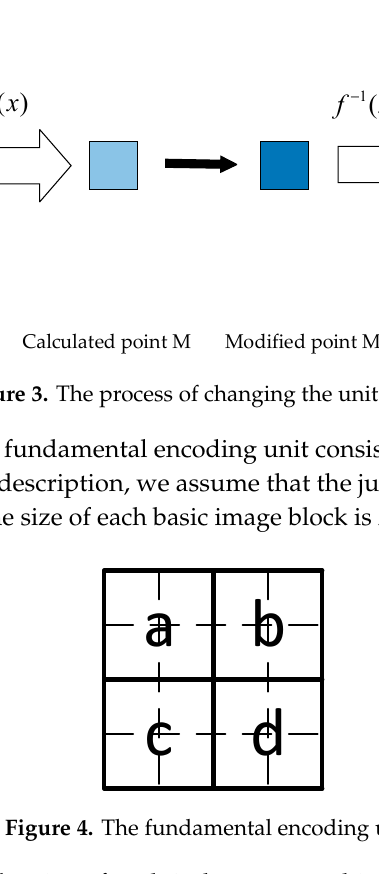
Figure 4. The fundamental encoding unit.